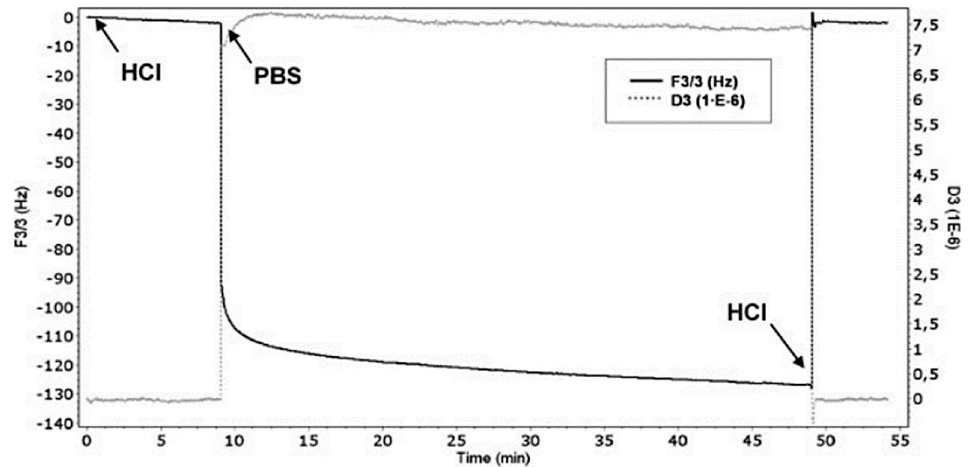
Figure 6. QCM-D study of the swelling–deswelling of PEGDA-co-AA hydrogel coating at different pH solutions. Arrows and labels indicate injections of HCl (pH 2.2) solution, PBS (pH 7.4), and the final HCl (pH 2.2) solution, respectively. (Reprinted with permission from [25], Whiley 2009 copyright n. 4710141377265).